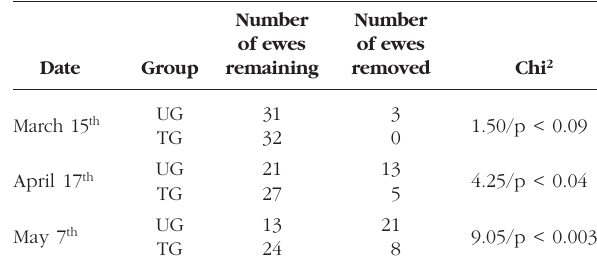
Table IV. – Contingency tables of the number of ewes that remained in milk and ewes that were removed from the trial because their milk production declined below the threshold level for ceased towards the end of the study. UG: untreated group and TG: monthly treated